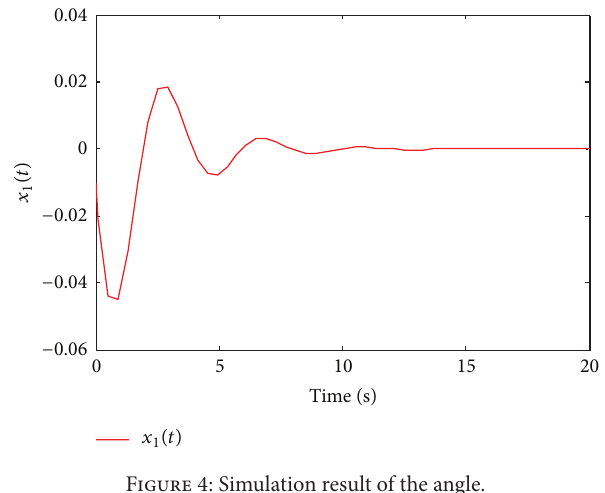
Figure 4: Simulation result of the angle.